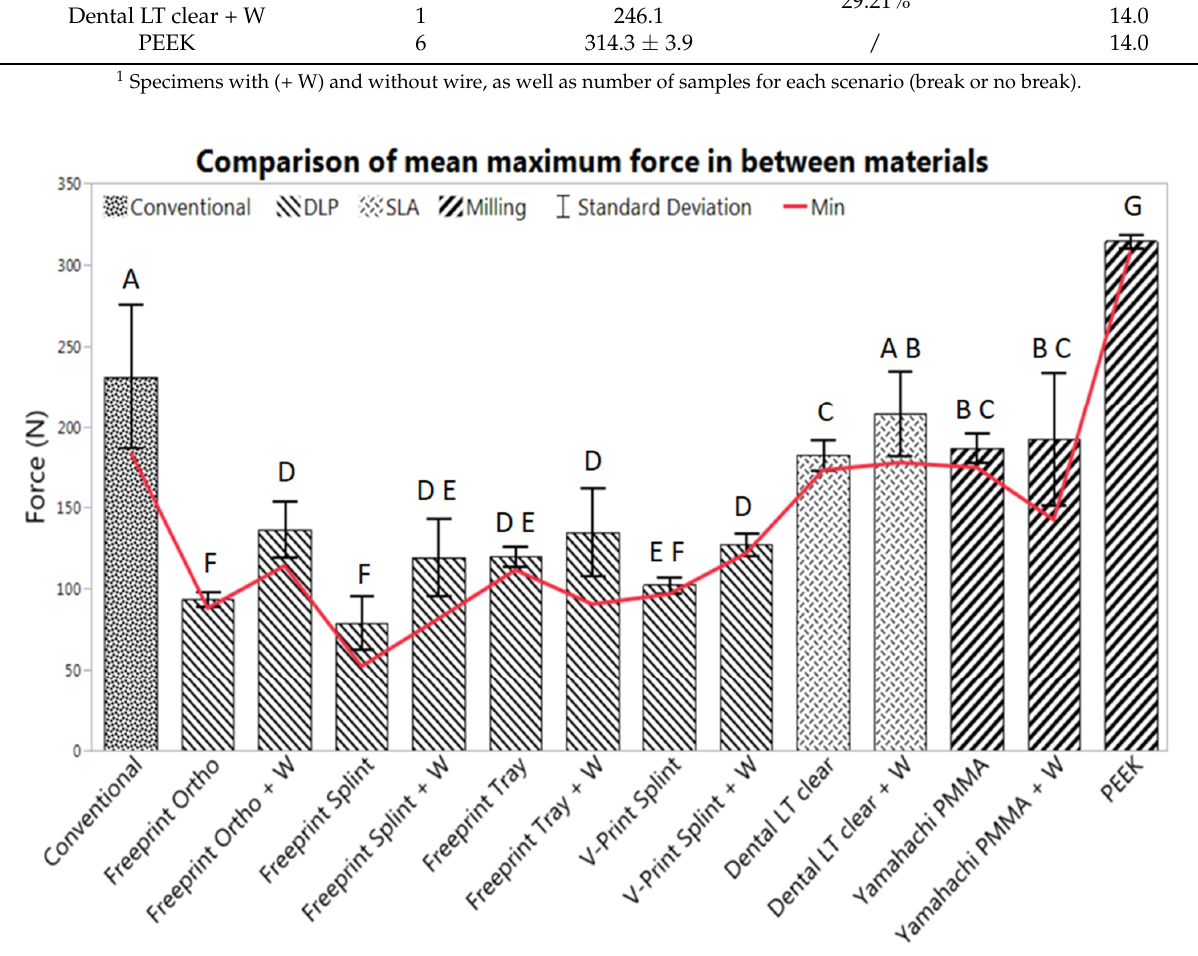
Figure 9. Mean max force (n = 6) and standard deviation, obtained from the TPPs manufactured by all evaluated materials with (+ W) and without wire. The conventional solution (Orthocryl + W) was compared to AM materials (middle group) and SM materials (right group). The letters denote the results of the paired Student’s t-test with a p -value of <0.05.